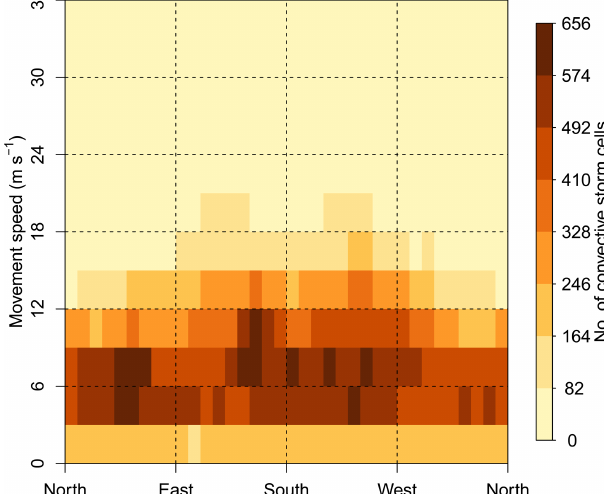
Figure 10. The 2-D histogram of the number of convective storm cells as a function of movement direction and storm speed, for the Prut River basin, between 2003 and 2017 (May–August).